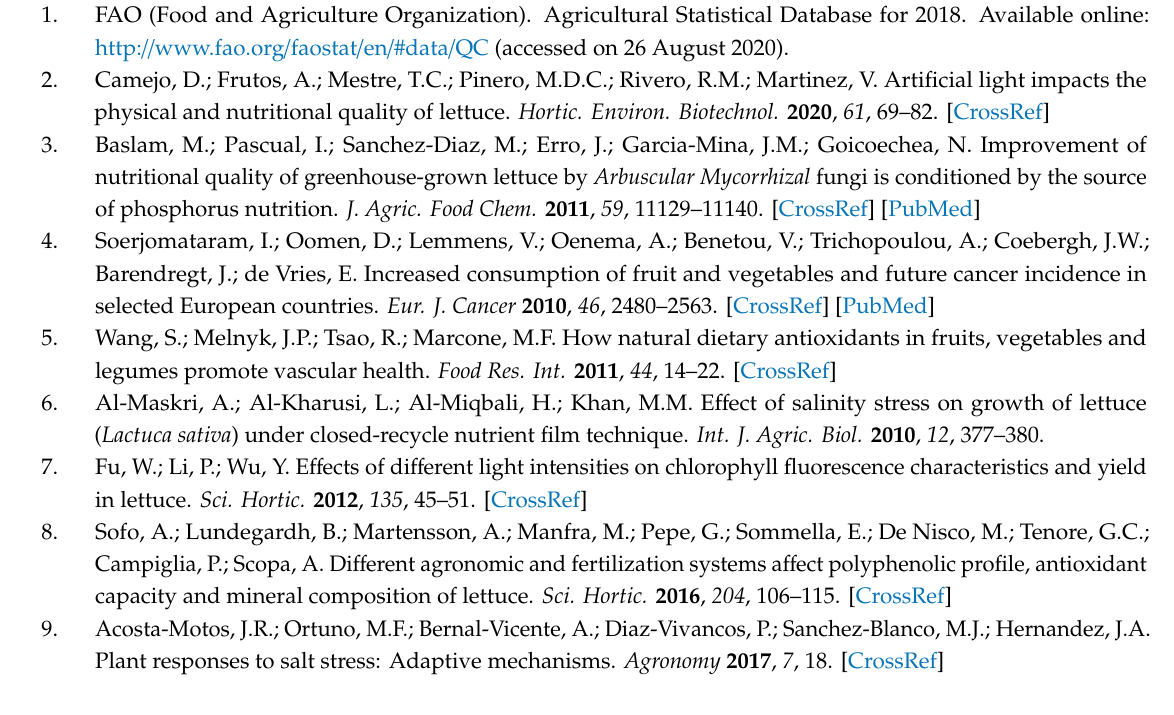
Figure S1: Correlation analysis among chlorophyll fluorescence parameters, growth parameters, nutritional compounds and antioxidant activities in lettuce seedlings at the last day of the experiment (8th day), Table S1: Chlorophyll fluorescence parameters measured for lettuce seedlings as a ff ected by NaCl concentrations during a progressive treatment time, Table S2: Proline, chlorophyll and ascorbic acid content in lettuce seedlings as a ff ected by NaCl concentration and treatment time, Table S3: Total phenol and total flavonoid content, and antioxidant activity in lettuce seedlings as a ff ected by NaCl concentration and treatment